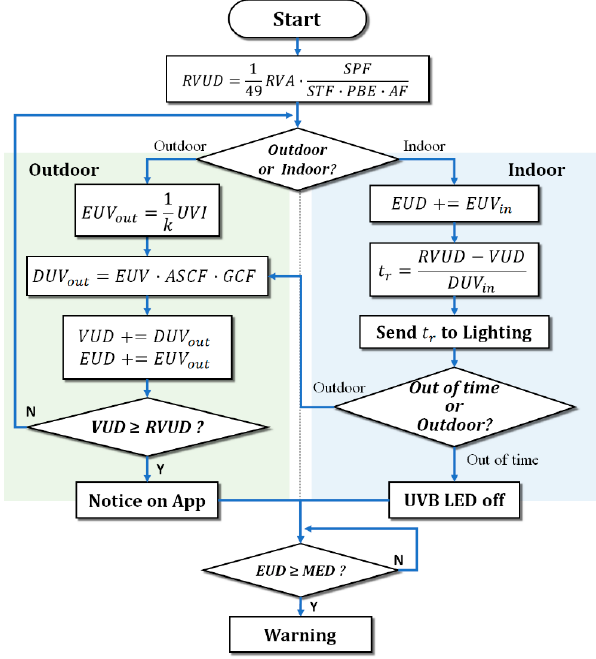
Figure 6. UVB LED general lighting and block diagram of UVB LED general lighting.